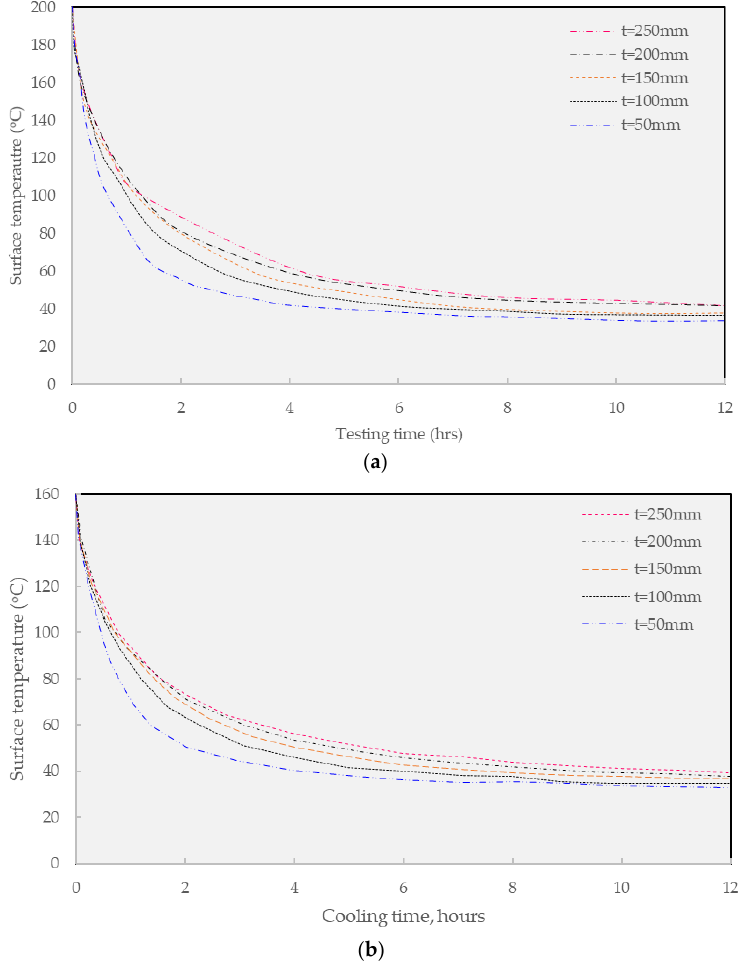
Figure 8. Pavements surface temperatures of FEA results. ( a ) Hot Mix Guss Mastic Asphalt; ( b ) Warm Mix Guss Mastic Asphalt.